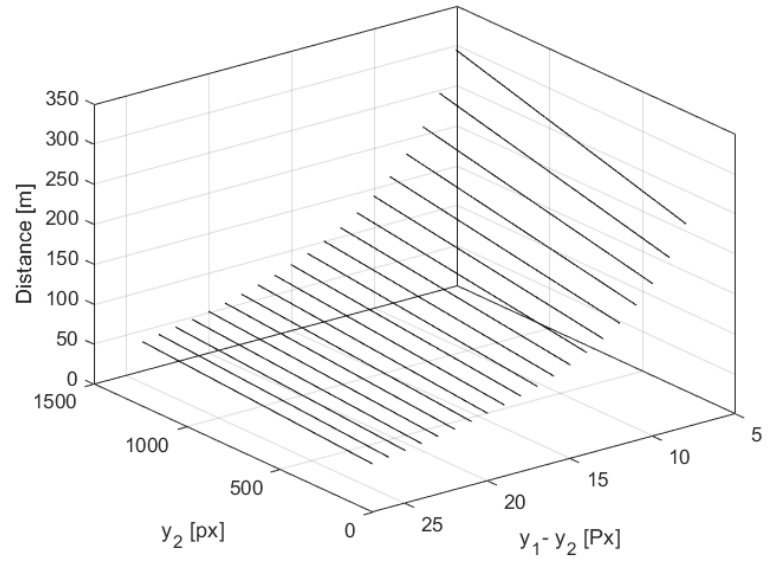
Figure 5. The distance measurement as a function of the pixel difference, ( y 1 − y 2 ) , and object position on the C 2 image plane, y 2 , within a range of 300 m.